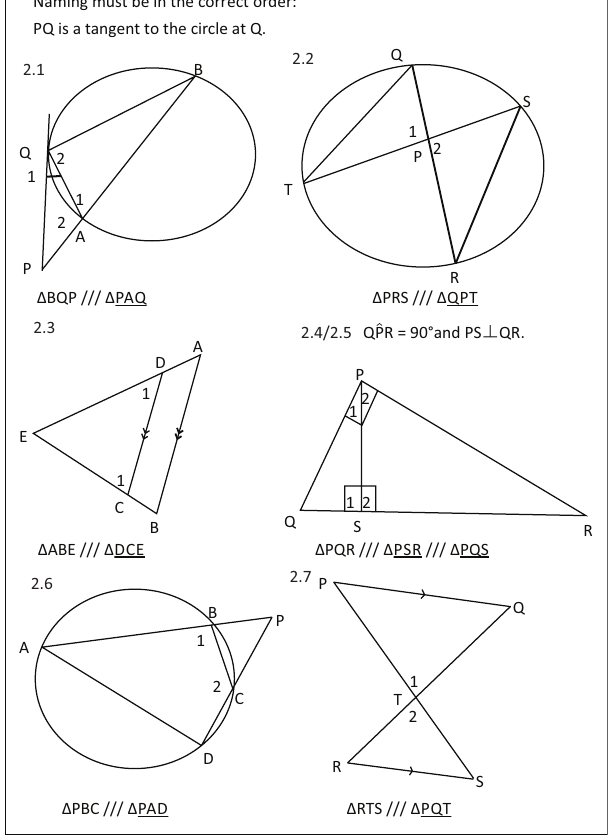
FIGURE 4: A representation of Celo’s